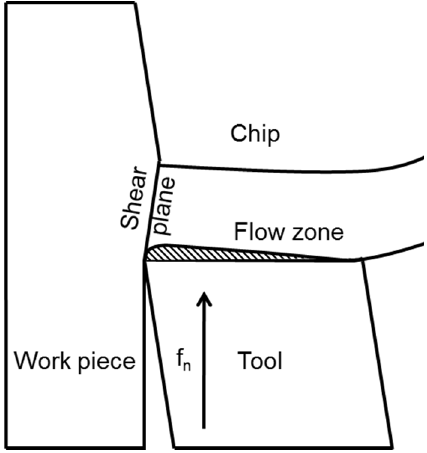
Figure 7. The chip formation process during turning